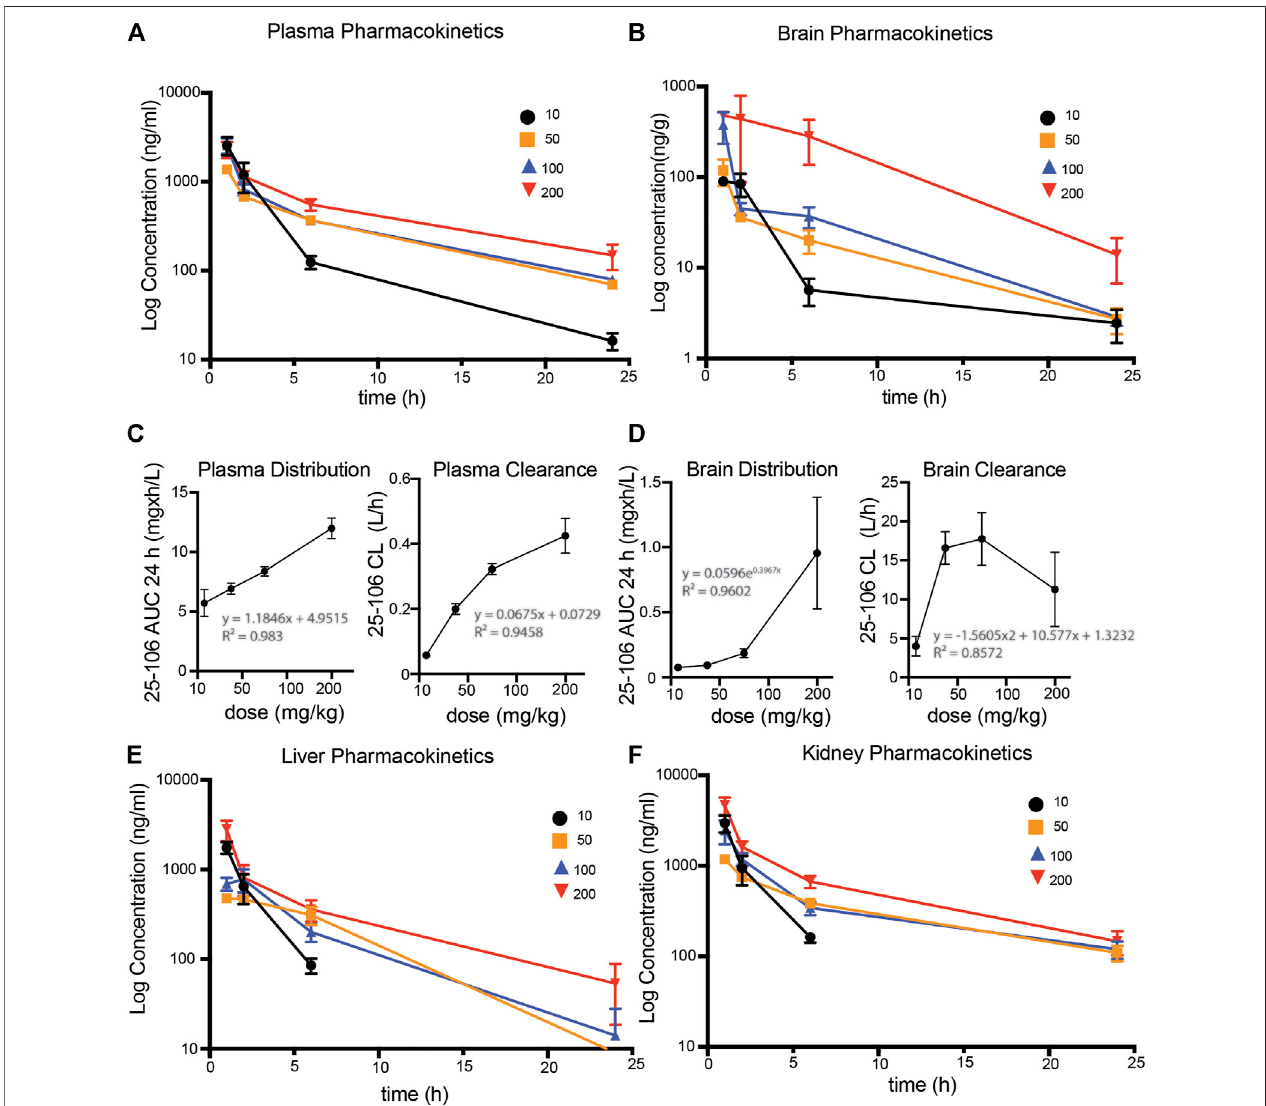
FIGURE6| Pharmacokinetic pro fi leof25 – 106 (A,B) .LC-MS/MSdetected25 – 106used at four doses(10, 50, 100,and 200 mg/kg)across1, 2,6, and 24 hpost injection in the plasma (A) and brain (B) . (C) distribution and clearance of 25 – 106 in plasma. (D) Distribution and clearance of 25 – 106 in the brain. (E,F) . LC-MS/MS detected a concentration of 25 – 106 in the liver (E) and kidney (F) ( n = 4 for each treatment).